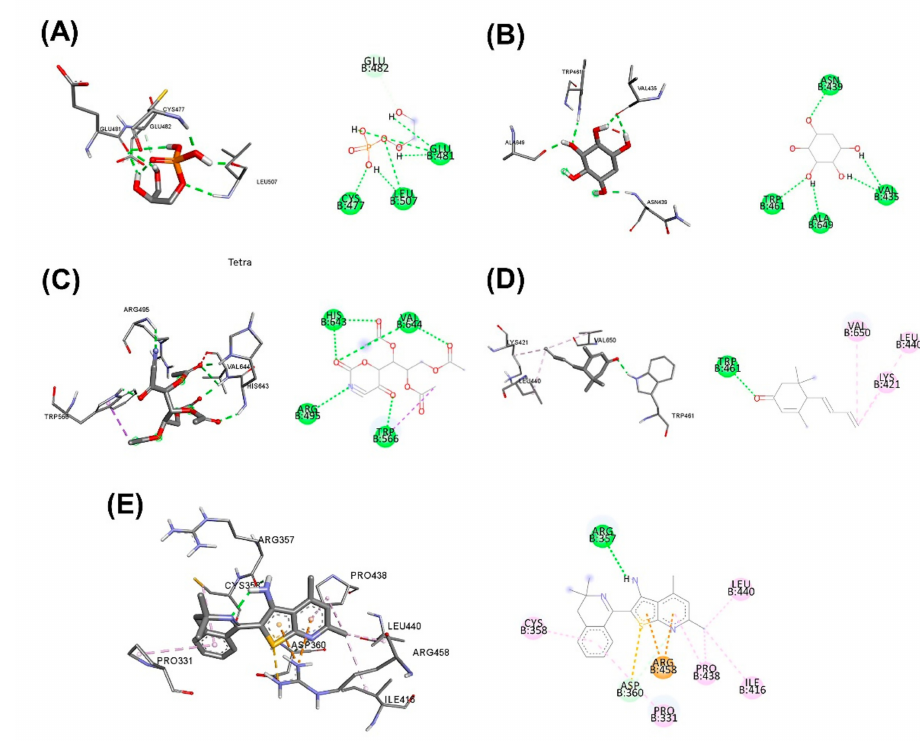
Figure 5. 3D (LHS) and 2D (RHS) Molecular docking pose visualization showing water extrac- tion of C. fenestratum : ( A ) Alirocumab, ( B ) Inositol, 1-deoxy-, ( C ) Tetraacetyl-d-xylonic nitrile, ( D ) Megastigmatrienone, ( E ) Thieno[2,3-b]pyridine, 3-amino-2-(3,3-dimethyl-3,4-dihydroisoquinolin- 1-yl)-4,6-dimethyl- interactions with PCSK9.